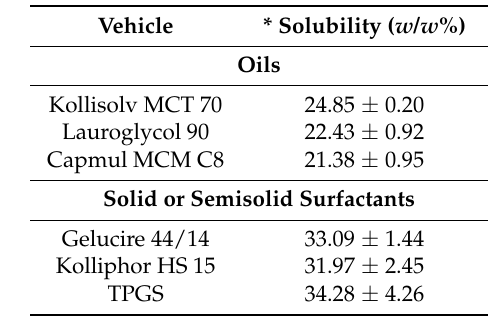
Table 3. Solubility of FL in surfactants and oils at 60 ◦